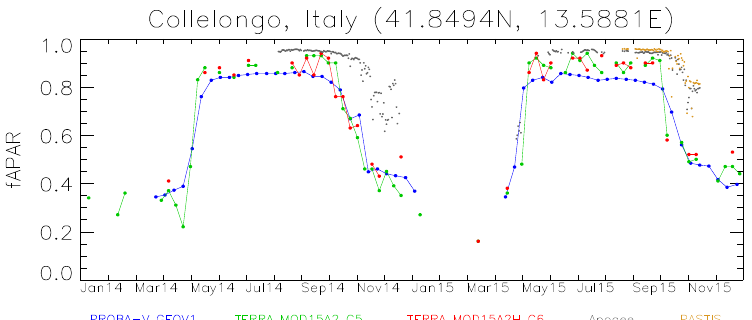
Figure 10. Temporal trends of green fAPAR from GEOV1, MODIS C5, and MODIS C6 satellite products over Collelongo flux tower (ESU 1), and continuous ground values of canopy fAPAR APOGEE and fAPAR PASTIS-AVG . Note that only pixels classified as ‘High Quality’ and ‘Useful’ according to Table 2 are displayed.